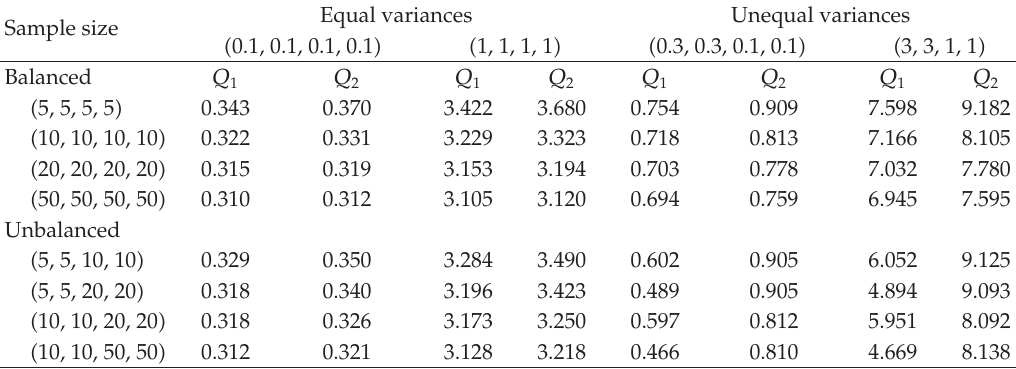
(cid:4) (cid:2) (cid:7) F α, (cid:13) ν · S 2 i in 2 1 , (cid:13) ν 2